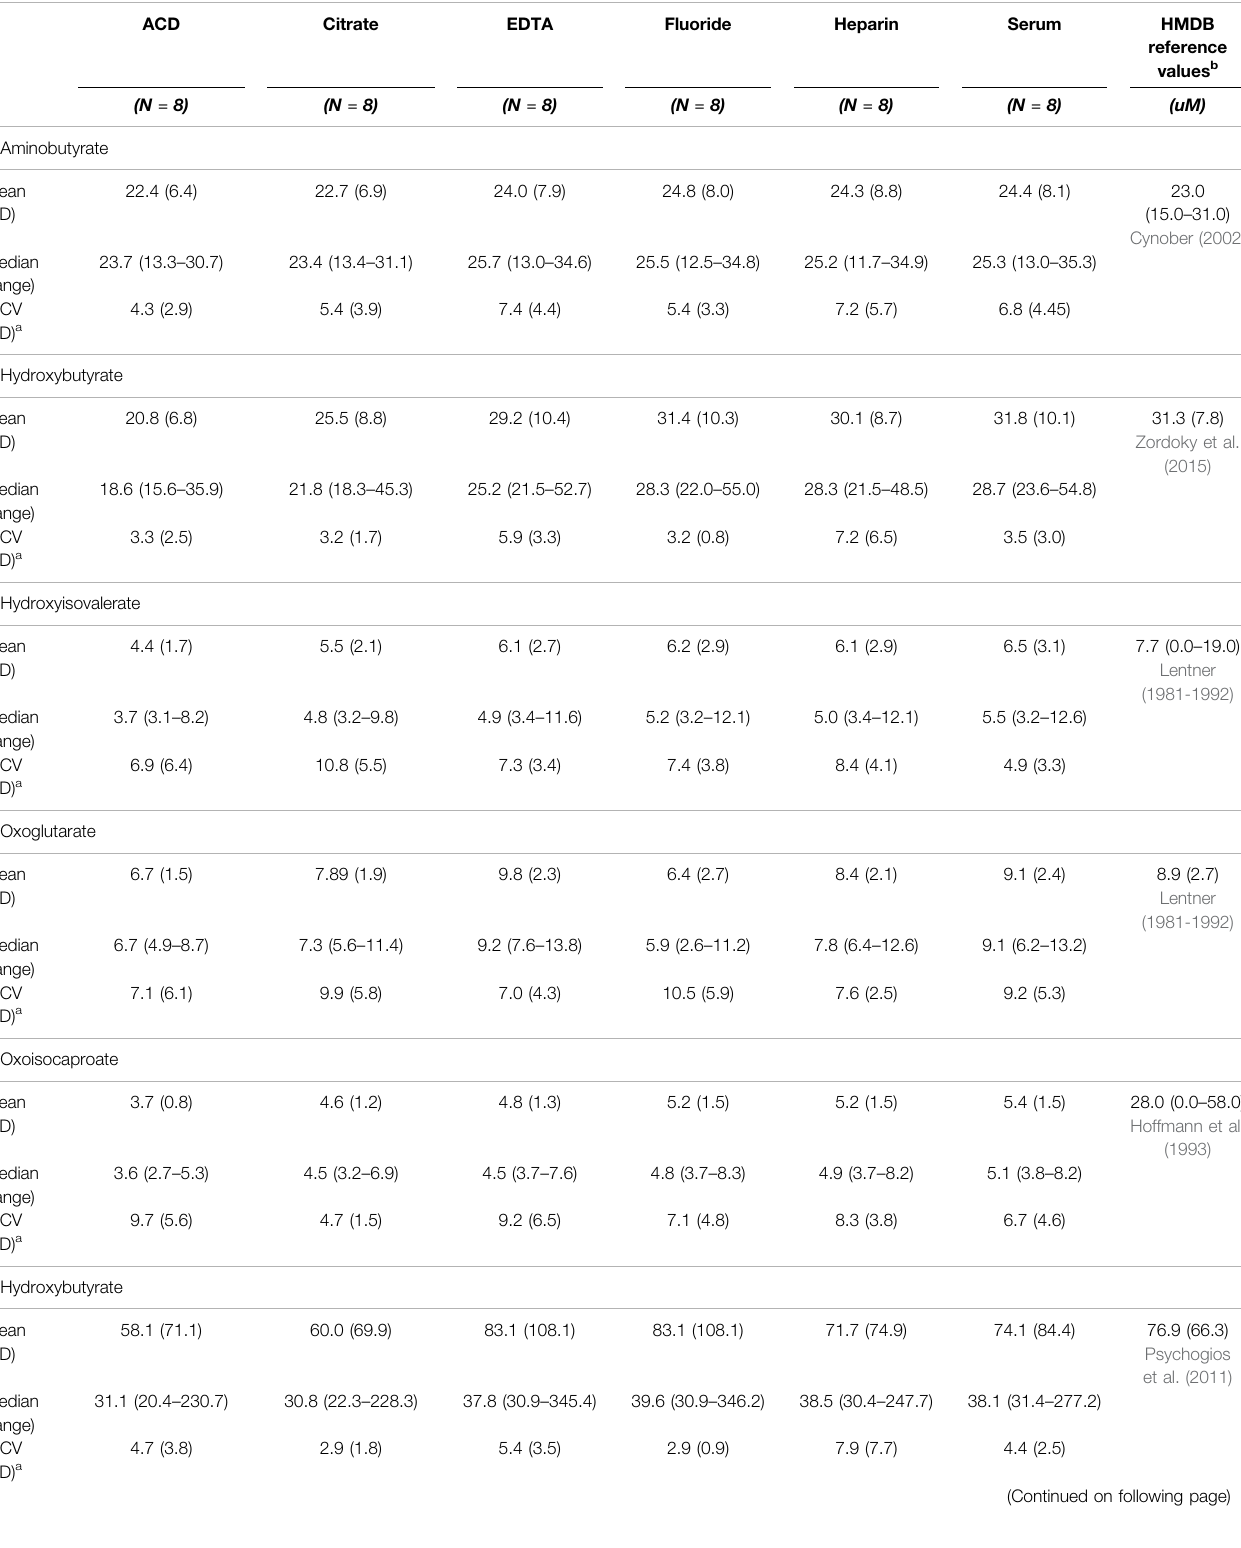
TABLE 1 | Blood metabolites measured using 1 H NMR spectroscopy. Metabolites are listed in alphabetical